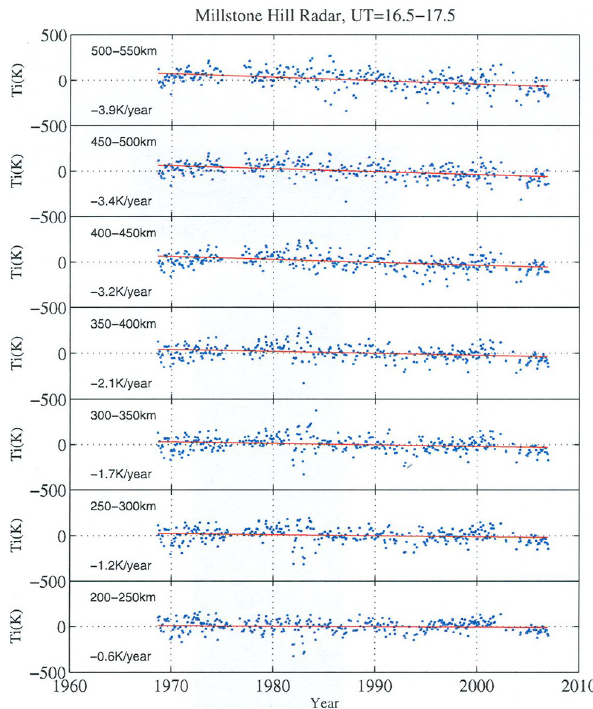
Fig. 2. Ion temperature ( T i ) data and trend at various heights in the F-region above 200km. The data points are a result after removing terms of background, F10.7, and ap. The red line is fit to data points to give the long-term trend value (marked at the bottom left corner in each panel). Adopted from Zhang et al.